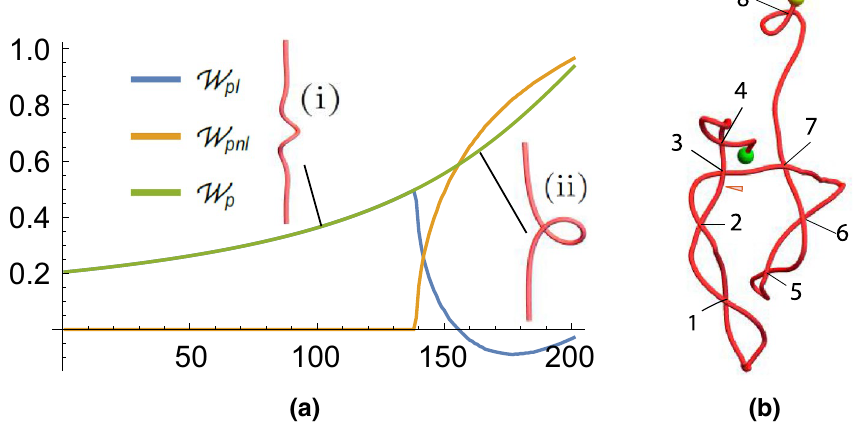
Figure 4. Polar writhe calculations of plectoneme geometries. ( a ) W p values of a loop forming curve deformation. ( b ) A curve with significant plectoneme structure. The individual loops present are